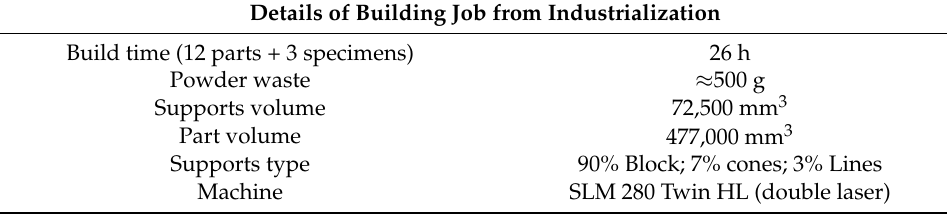
Table 2. Industrialization